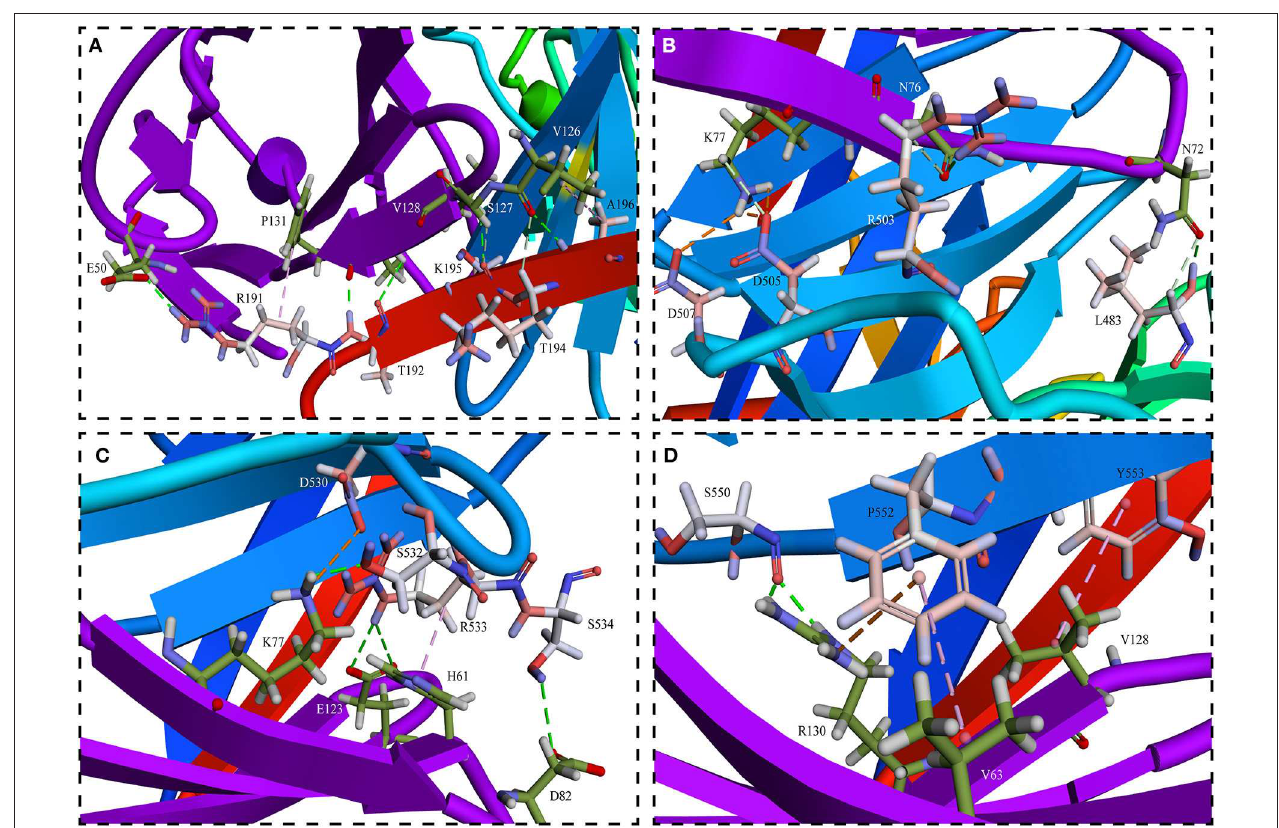
FIGURE 4 | Detailed views of (A–D) in the interface between PPRV HNw and hSLAM. (A) The interface of PPRV HNw–hSLAM complex, the successional interaction comprised of β -sheet R191-K196 on the PPRV HNw β 6 sheets and K126-P131 on the hSLAM G β -sheets made the complex in a more stable state. And R191 of PPRV HNw made the intermolecular Pi interaction with P131 of hSLAM, which might play an important role in stabilizing the PPRV HNw-hSLAM complex. (B) The residues D505 and D507 on PPRV HNw made the strong salt bridge with K77 on hSLAM might also play an important role in stabilizing the PPRV HNw–hSLAM complex. (C) Key residues D530 and R533 of PPRV HNw made hydrogen bonds and Pi interaction with the residues of hSLAM. (D) The strong Pi interaction comprised of residues F552 on PPRV HNw and K64 and R131 on hSLAM. Other residues L483, R503, S532, S534, S550 also made a large number of hydrogen bonds with the